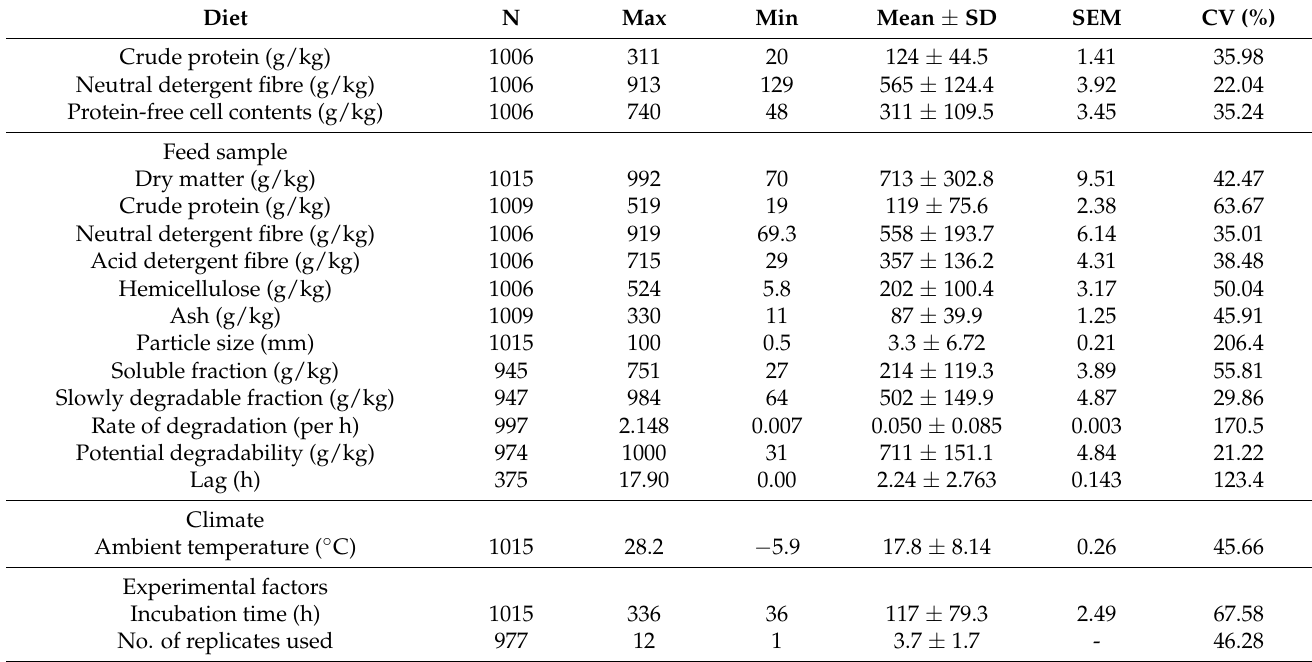
Table 1. Descriptive statistics of diet, feed and climatic factors affecting degradation of feeds in the